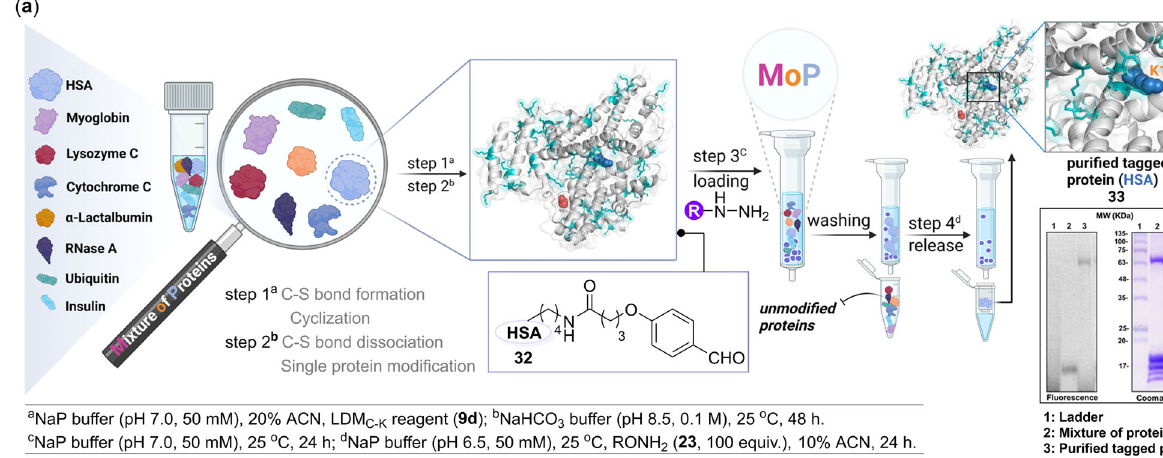
capturesandenrichesthebioconjugatebyorderedon-resinimmobilizationallowing recovery of unlabeled proteins. Next, the transoximization and centrifugal spin concentration render analytically pure single-site tagged protein